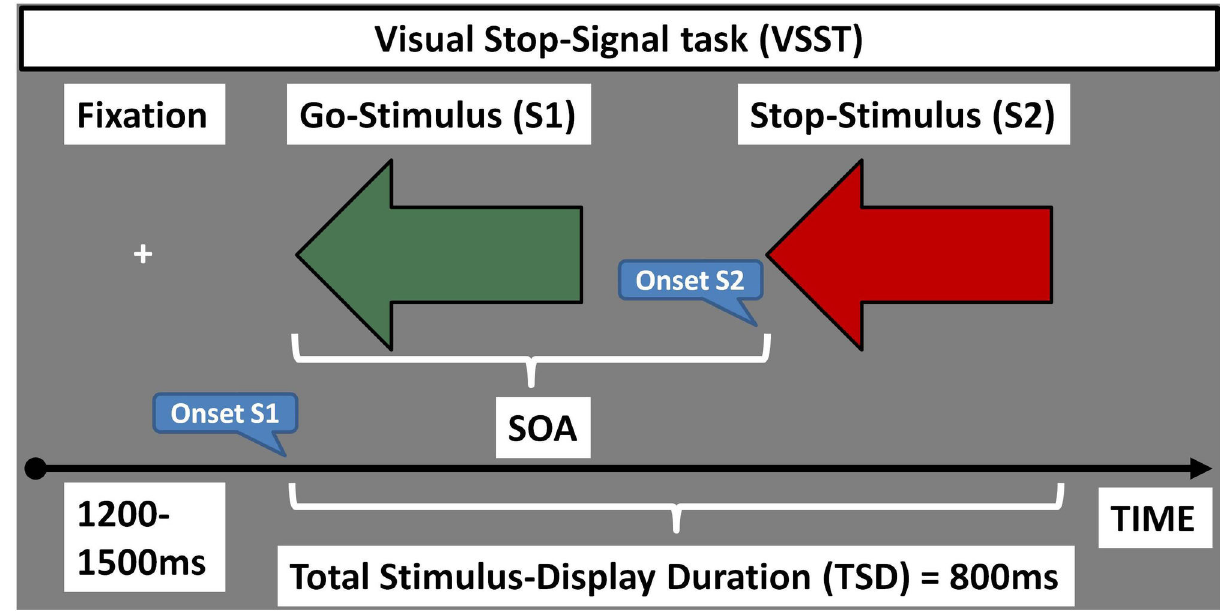
Figure 1. Visual Stop-signal task (VSST): Participants responded to the direction of a central green arrow (“Go-stimulus”), and withheld their response when the arrow turned red (“Stop-stimulus”) in the classic variant of the task. In the control variant, participants were told to respond as they would normally to the direction of the “Go-stimulus” irrespective of whether it was followed by a “Stop-stimulus”. In both variants of the VSST, each trial began with the presentation of a fixation cross of varied duration. On “Stop-trials”, the “Go-stimulus” was replaced, following a varied Stimulus Onset Asynchrony (SOA), by the “Stop- stimulus”. In the classic variant, the SOA increased or decreased by 50msec as a function of whether participants were correct or not, respectively, at inhibiting their response to the “Stop-stimulus”. In the control variant, the SOA also varied in 50msec increments, but randomly. The total stimulus-display duration (TSD) was